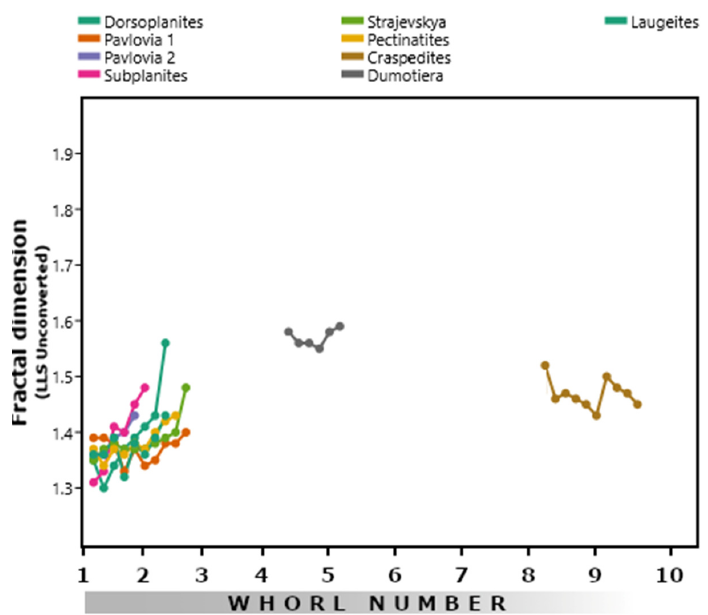
Figure 6. Ontogenetic sequences of perisphinctid suture complexity. The fractal dimensions can be found in File S1 in the Supplementary Materials.